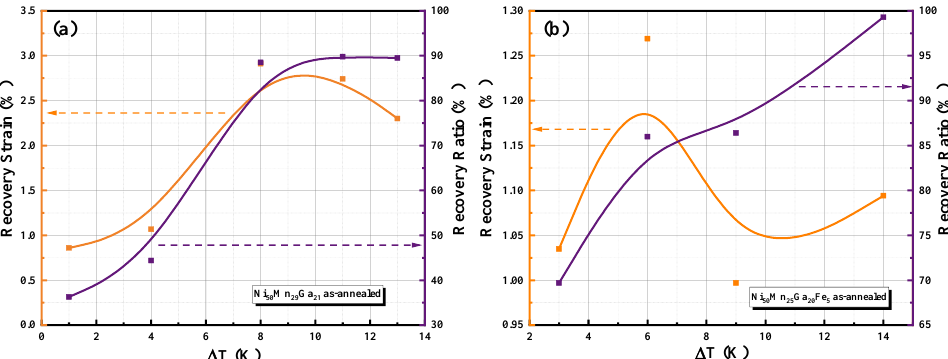
Figure 8. ( a ) Relationship curves of recoverable strain, strain recovery rate and temperature difference for Ni 50 Mn 29 Ga 21 microwires, ( b ) Relationship curves of recoverable strain, strain recovery rate and temperature difference for Ni 50 Mn 25 Ga 20 Fe 5 microwires.